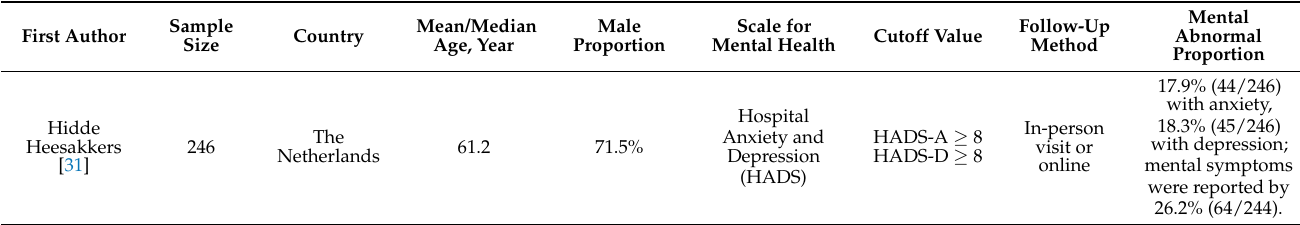
Table 3. Studies on mental health of COVID-19 survivors at 1-year